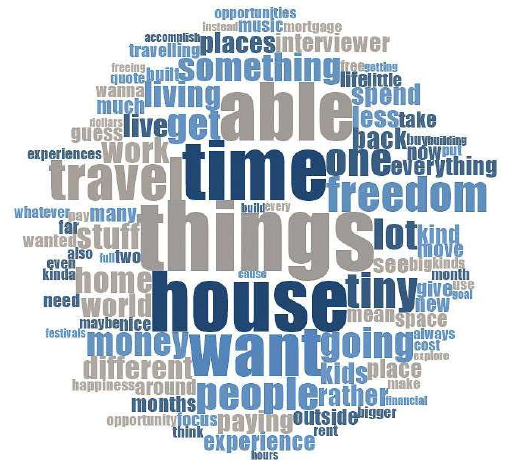
Figure 6. Word cloud for Motivator 5.